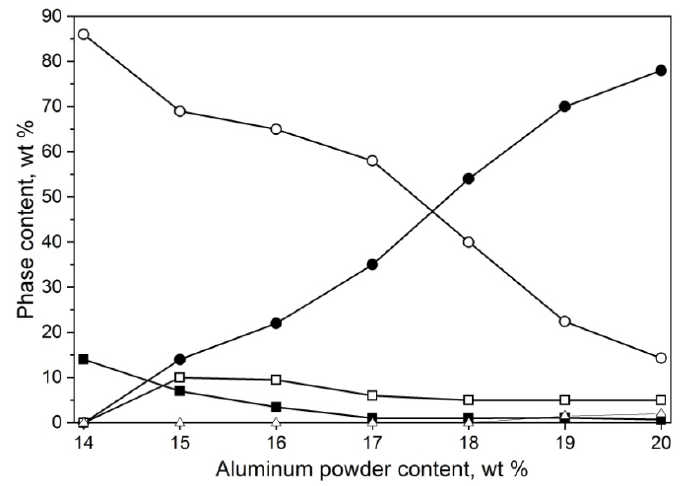
Figure 3. Phase composition of powder mixtures obtained by the means of SHS method from mixes of powders with 14–20 wt% aluminum content and medium alumina EA-1200 powder synthesized under 1 MPa nitrogen, γ -AlON ( ● ), Al 2 O 3 ( ○ ), AlN ( □ ), Al ( ■ ), and Al 7 O 3 N 5 ( ∆ ).